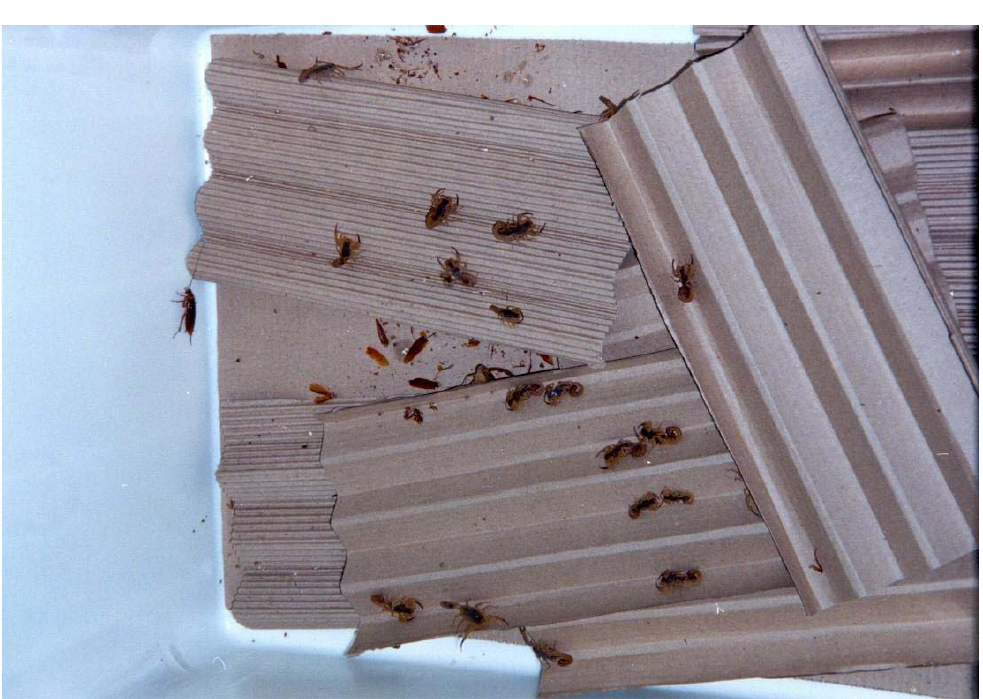
Figure 4 . Feeding with Periplaneta americana . D. M. Candido.